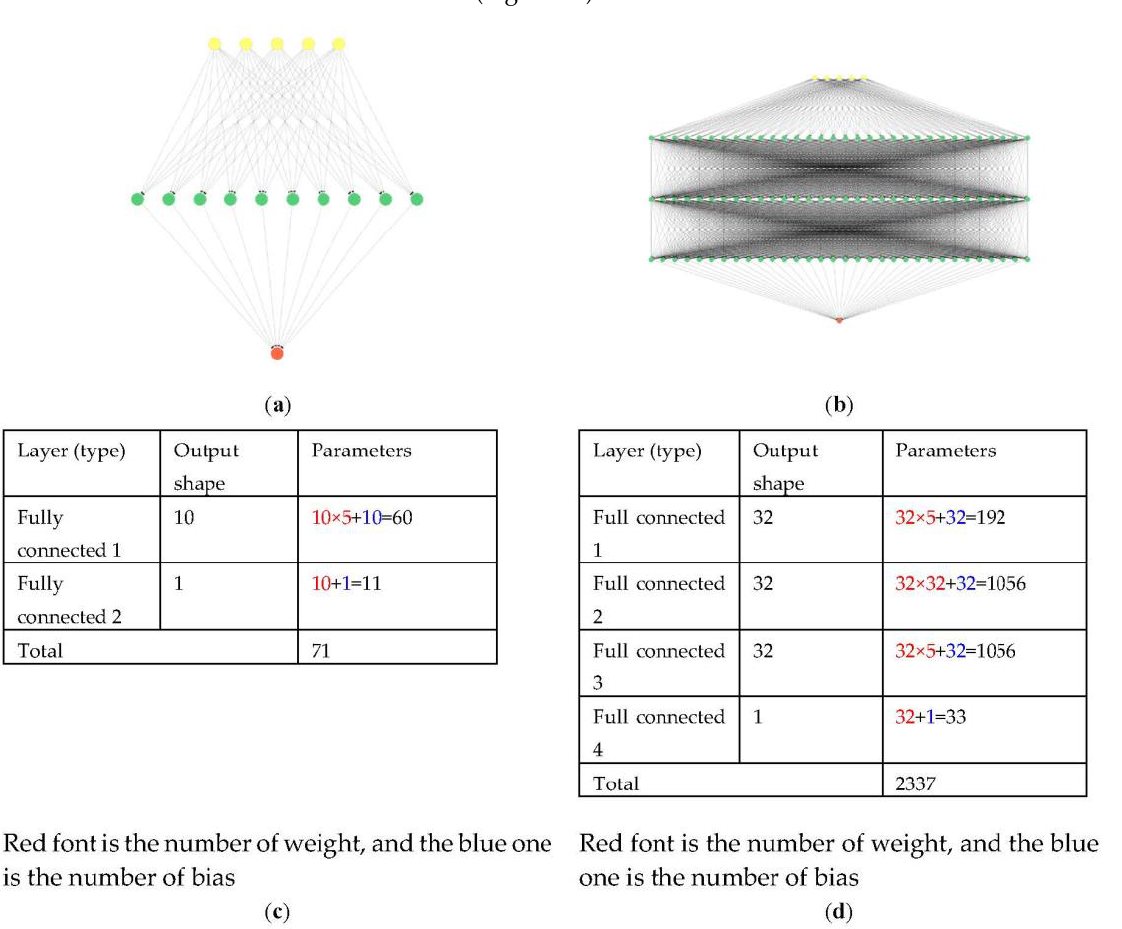
Figure 11. Comparison of prediction errors between the deep network and the shallow network: ( a ) shallow network diagram; ( b ) deep network diagram; ( c ) trainable parameters of the shallow net- work; ( d ) trainable parameters of deep network; ( e ) training error (blue curve) and test error (red curve) of the shallow network; ( f ) training error (blue curve) and test error (red curve) of deep net- work. 5.5. Construction of the Network A wide and deep neural network was constructed with five nodes in the input layer whose number is identical to selected feature curves and three hidden layers. The input layer is identical with the number of the selected feature curves; if we added more irrele- vant curves, the accuracy and stability of the trained model would be downgraded. The number of neurons in each hidden layer is 32, the output layer has one node, and all layers are fully connected. The activation function of each layer is Elu, the loss function is MAE, and the parameter updating algorithm of the neural network is Adam. The trainable pa- rameters of this network are up to 2337 (the optimization of the parameters for network